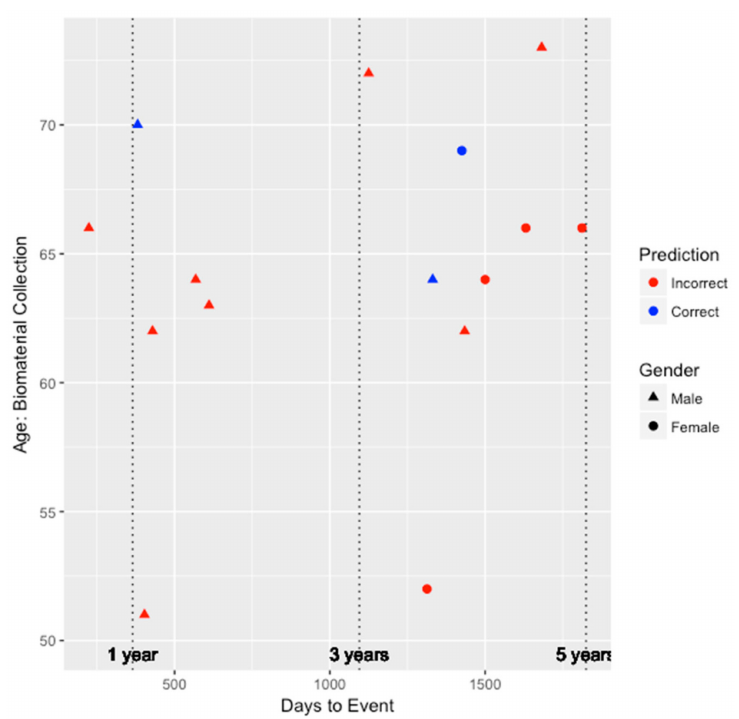
Figure 2. The performance of the Framingham risk score model when identifying those at high risk of symptomatic CHD within five years by age, gender, and days to event.